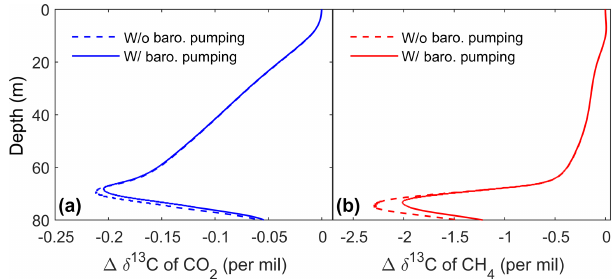
Figure 14. Diffusive fractionation effect at the time of sampling at WAIS Divide on δ 13 C of (a) CO 2 and (b) CH 4 . Atmospheric mix- ing ratios of 12 CO 2 , 13 CO 2 , 12 CH 4 , and 13 CH 4 were obtained from atmospheric trace gas histories used to drive the firn air model (see Supplement) and assuming constant atmospheric isotope ratios of 13 C-CH − 8 and − 47‰ for δ 13 C-CO 2 and δ 4 , respectively. Firn air values are presented as the difference from the constant atmospheric isotope